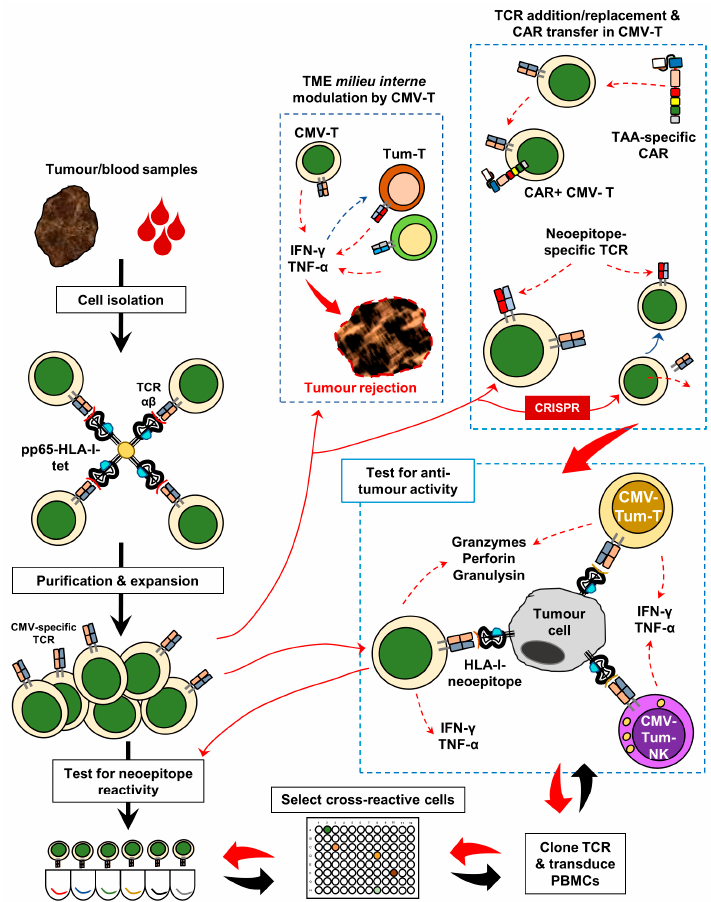
Figure 2. The CMV-based precision immunotherapy development: A potential strategy to isolate Figure 2. The CMV ‐ based precision immunotherapy development: A potential strategy to isolate CMV- and tumour-reactive TCRs from tumour tissue and / or blood samples for developing targeted CMV ‐ and tumour ‐ reactive TCRs from tumour tissue and/or blood samples for developing targeted T cell-based therapies using CMV-pp65 as a model antigen as described in the main text. Further, to T cell ‐ based therapies using CMV ‐ pp65 as a model antigen as described in the main text. Further, to infiltrating T cells, “bystander” CMV-specific T cells in the TME via the local production of IFN- γ and infiltrating T cells, “bystander” CMV ‐ specific T cells in the TME via the local production of IFN ‐γ TNF- α , may trans-activate endogenous TIL with neoepitope TCRs to jointly enhance the antitumour and TNF ‐α , may trans ‐ activate endogenous TIL with neoepitope TCRs to jointly enhance the response and potentiate tumour rejection. Legend: CMV-T = CMV-specific T cells; TCR = T-cell antitumour response and potentiate tumour rejection. Legend: CMV ‐ T = CMV ‐ specific T cells; TCR = receptor; pp65-HLA-I-tet = HLA class I tetramer; CMV-Tum-T = CMV-tumour neoepitope-specific T ‐ cell receptor; pp65 ‐ HLA ‐ I ‐ tet = HLA class I tetramer; CMV ‐ Tum ‐ T = CMV ‐ tumour TCR-transferred T cell; CMV-Tum-NK = CMV-tumour neoepitope-specific TCR-transferred NK cell; CAR = chimeric antigen receptor; CRISPR = clustered regularly interspaced short palindromic repeats; IFN- γ = interferon gamma; TNF- α = tumour necrosis factor